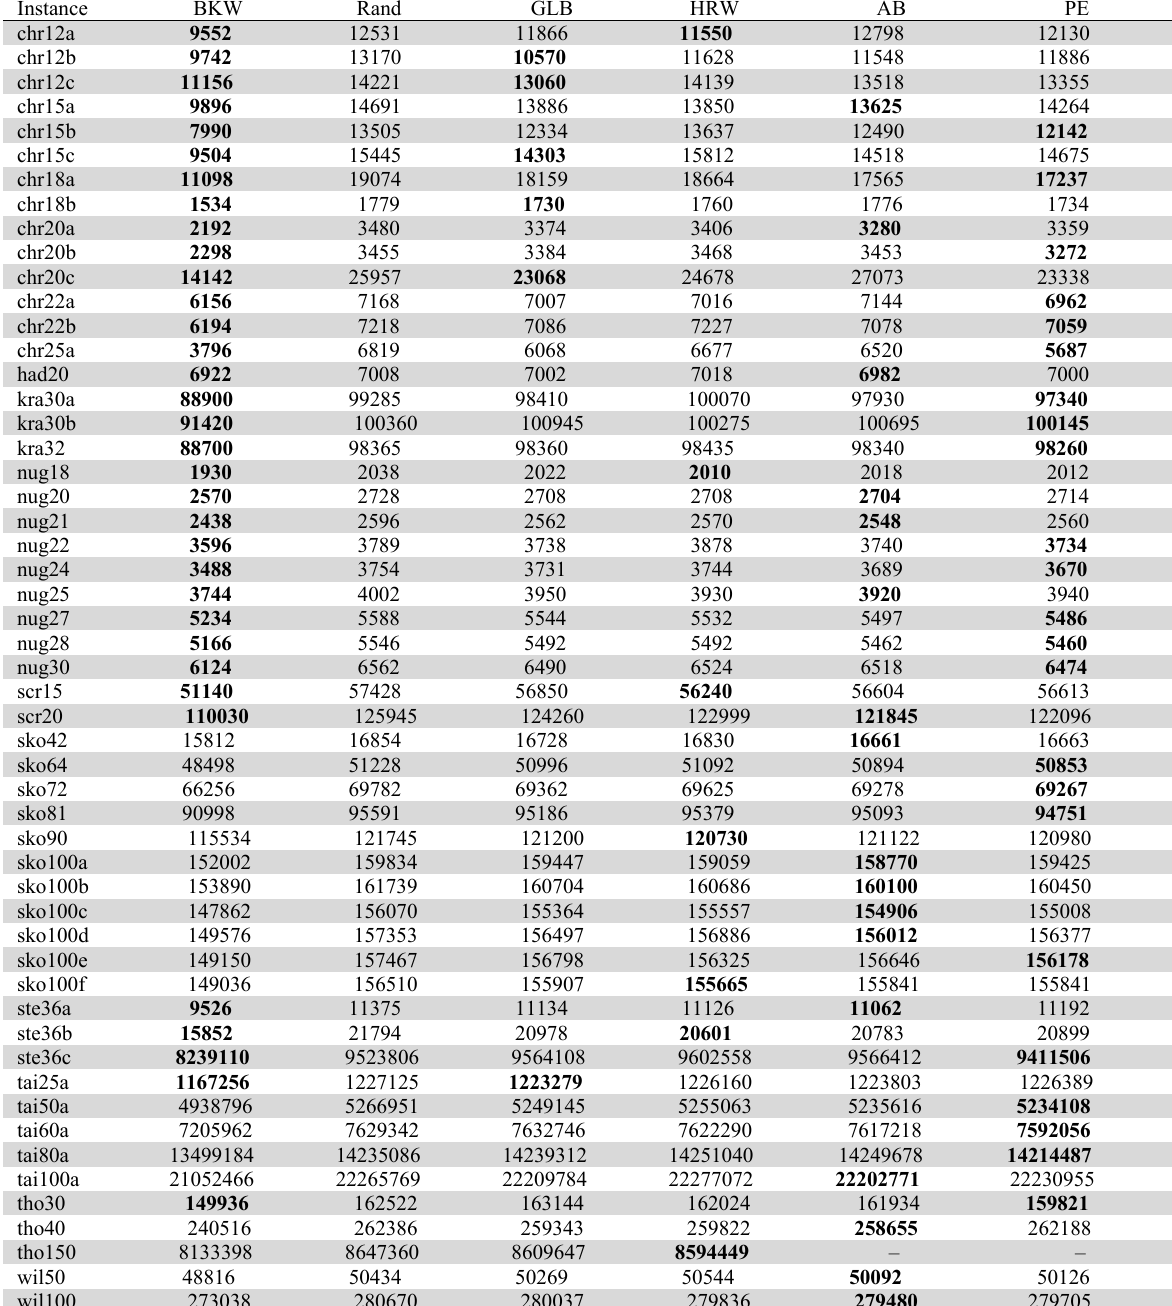
Median results from the simulations. If the BKW is confirmed optimal, it is highlighted in bold. Also, in bold is the method that produced the lowest median value for the given instance.